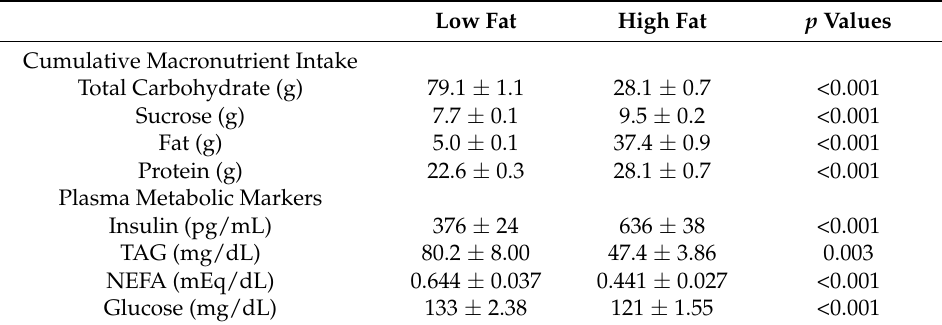
Figure 3. Plasma NEFA concentrations during the hepatic triacylglycerol production test (HTPT) in male C57BL/6J mice fed a low ‐ fat (LF) or high ‐ fat (HF) diet for 4 weeks. Mice were fasted 5–6 h prior to the HTPT (postabsorptive). Blood was sampled via a tail vein nick at 0 h (baseline), 0.5, 1, 2, and 6 h. One mouse was excluded from the NEFA data due to limited sample volume. Mean ± SEM. LF n = 9; HF n = 10.